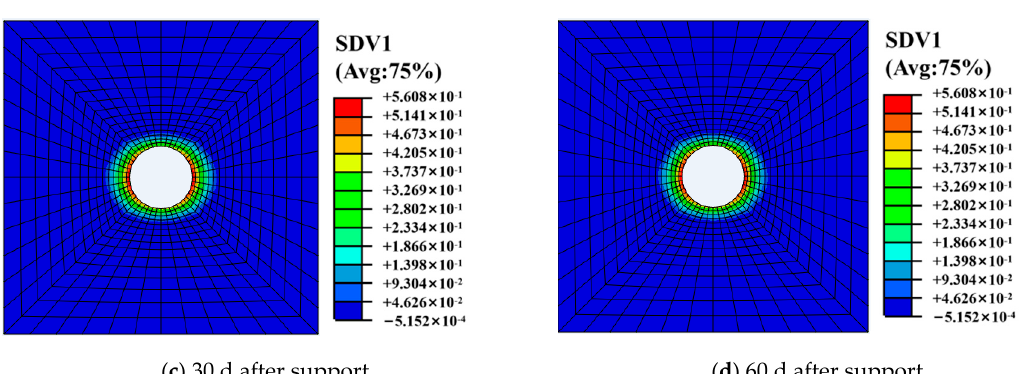
Figure 8. Distribution of surrounding rock damage at different times.